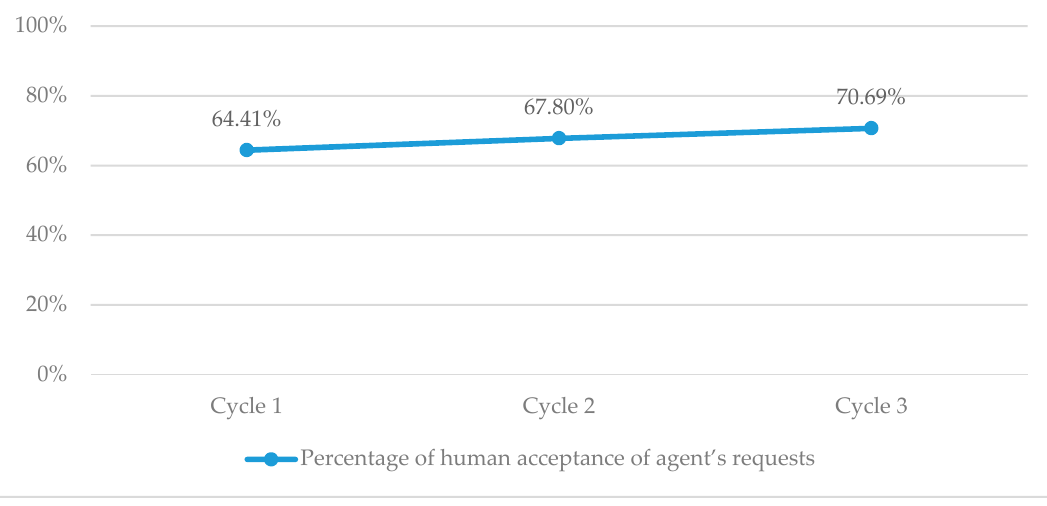
Figure 4. Evaluating the agent’s perlocutionary acts.